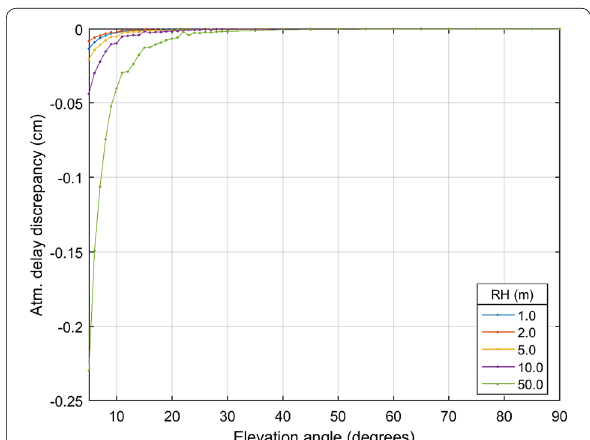
Fig. 4 Discrepancy in interferometric atmospheric delay between RM and RI formulations as a function of satellite elevation angle (for multiple reflector heights)